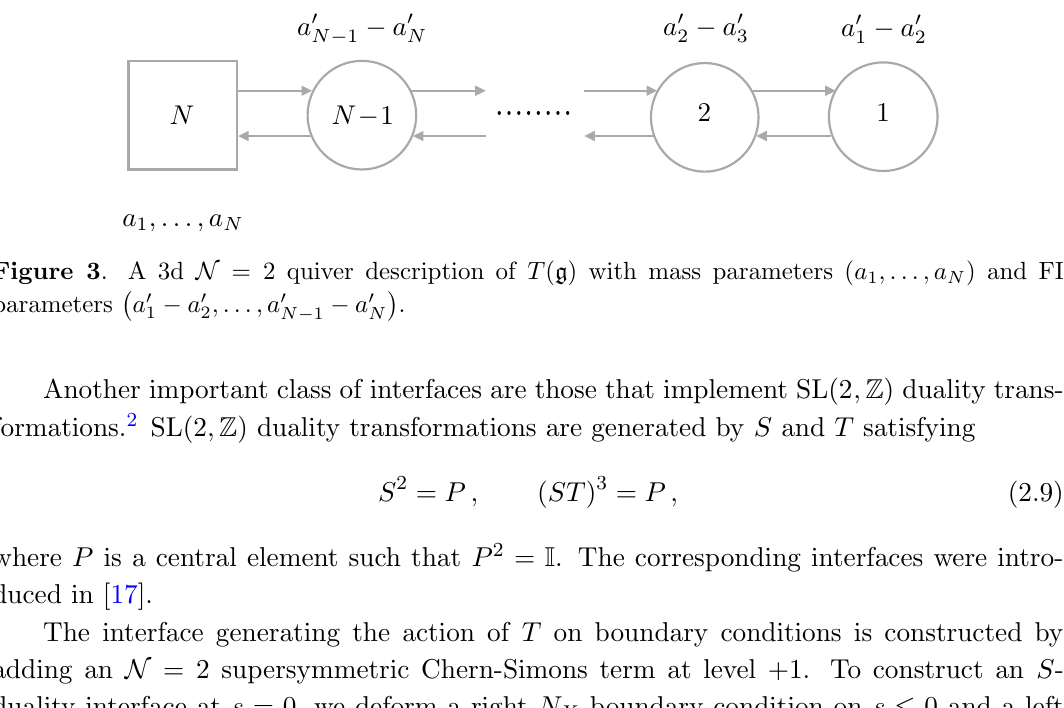
Figure 3 . A 3d parameters